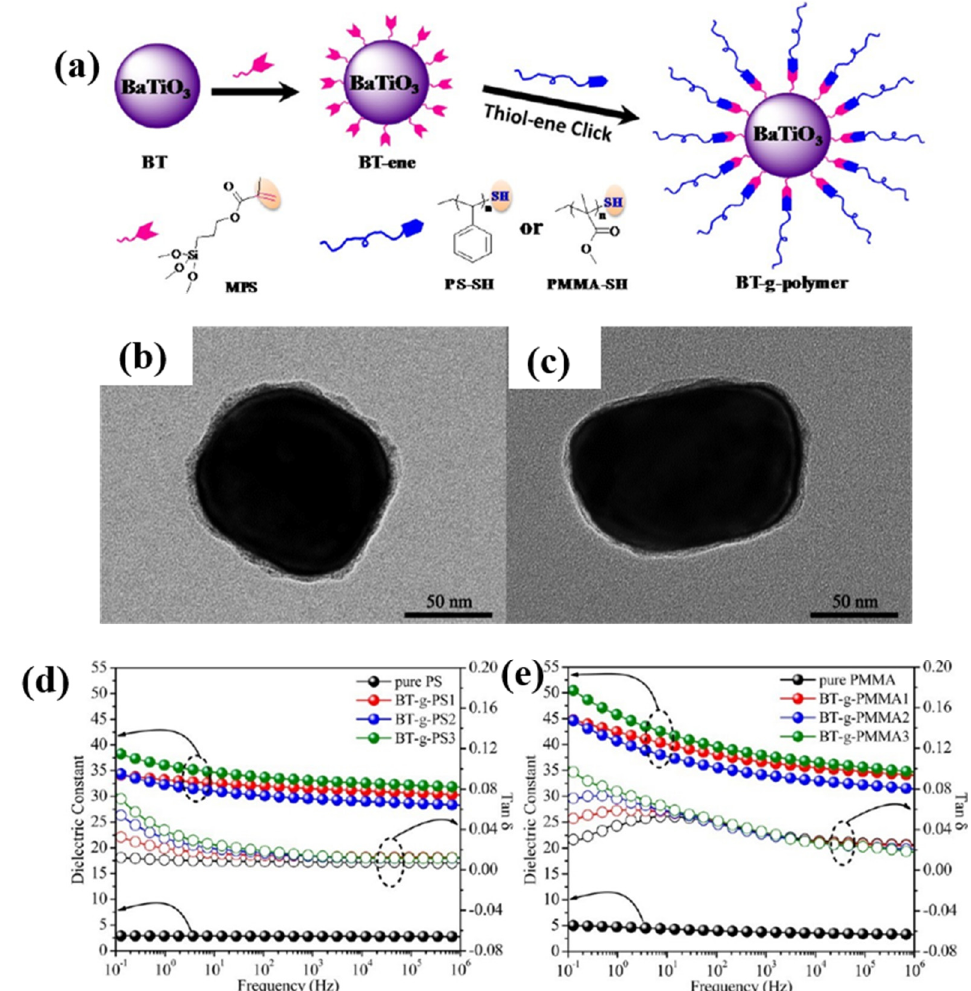
Figure 7. ( a ) Preparation of core-shell structured polymer@BaTiO 3 Nanoparticles. ( b ) PS@BaTiO 3 nanoparticle and ( c ) PMMA@BaTiO 3 at high magnification. Dielectric properties of PS@BaTiO 3 ( d ) and PMMA@BaTiO 3 ( e ) composites. Adapted with permission [90]. Copyright 2014, American Chemical Society.